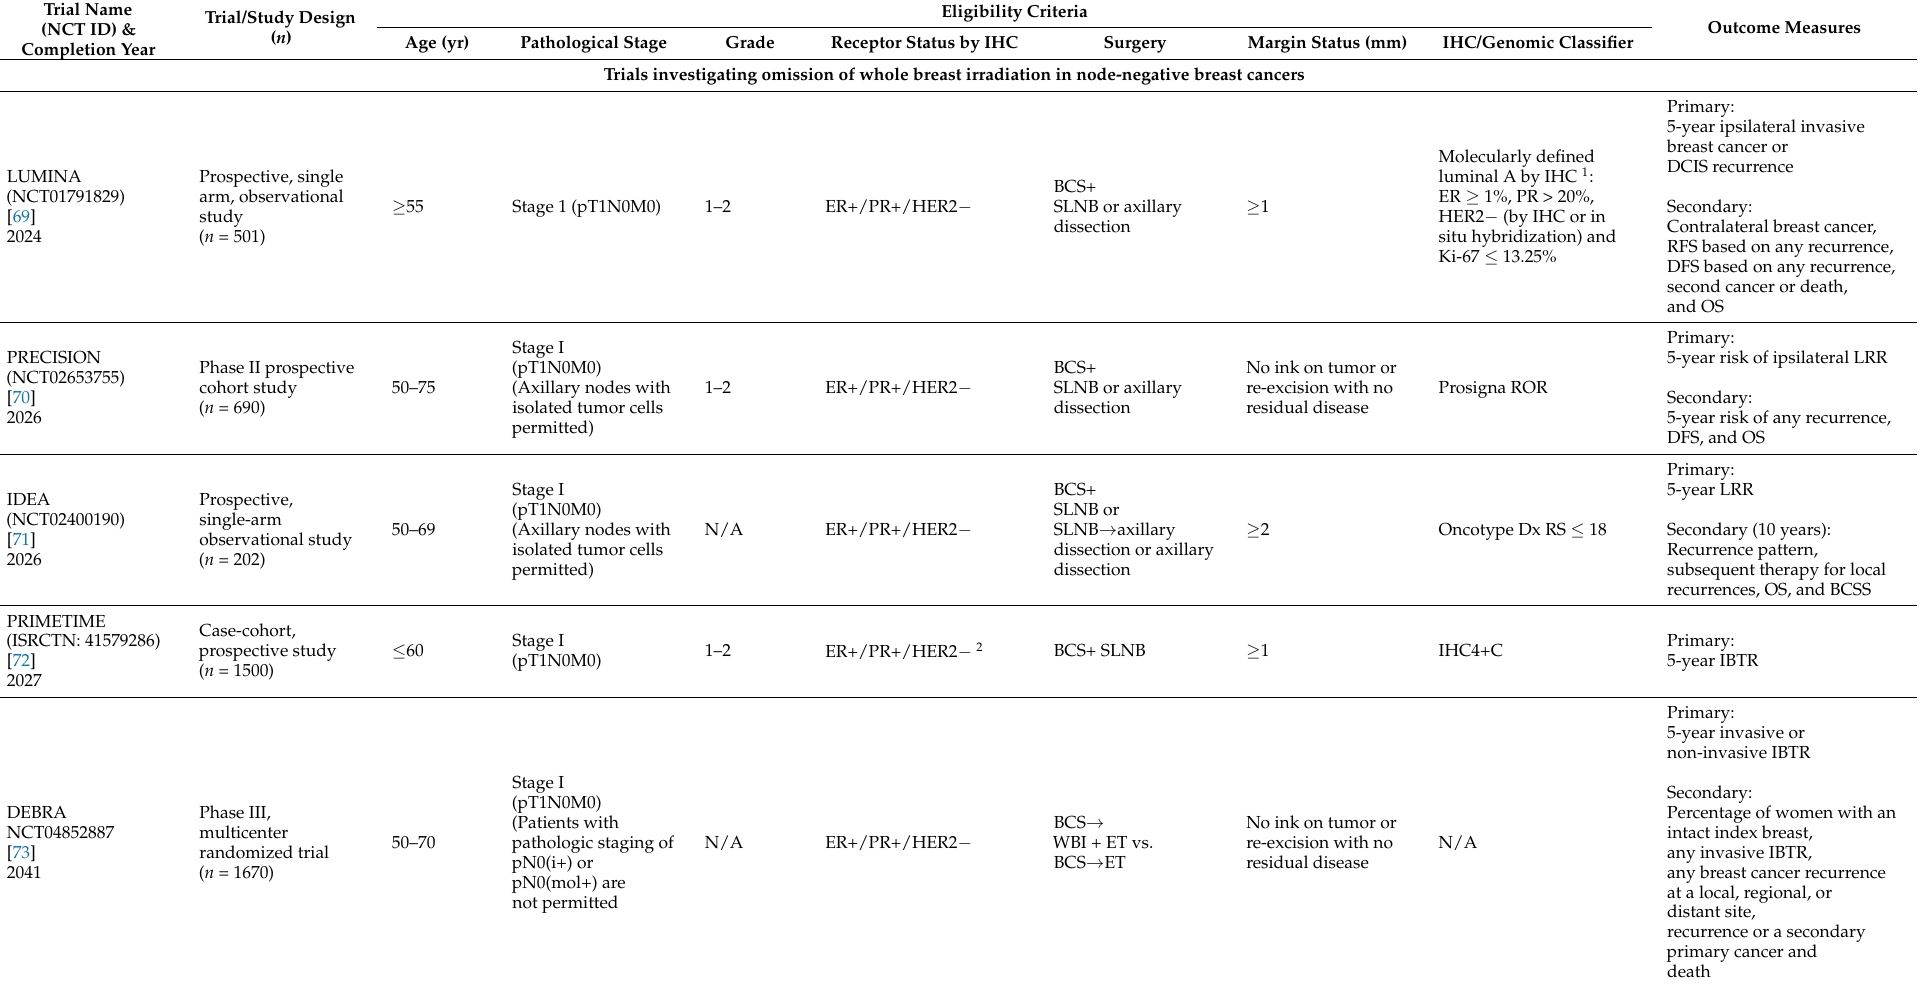
Table 1. Ongoing clinical trials for the omission of adjuvant radiation therapy in molecularly defined low-risk estrogen receptor-positive breast